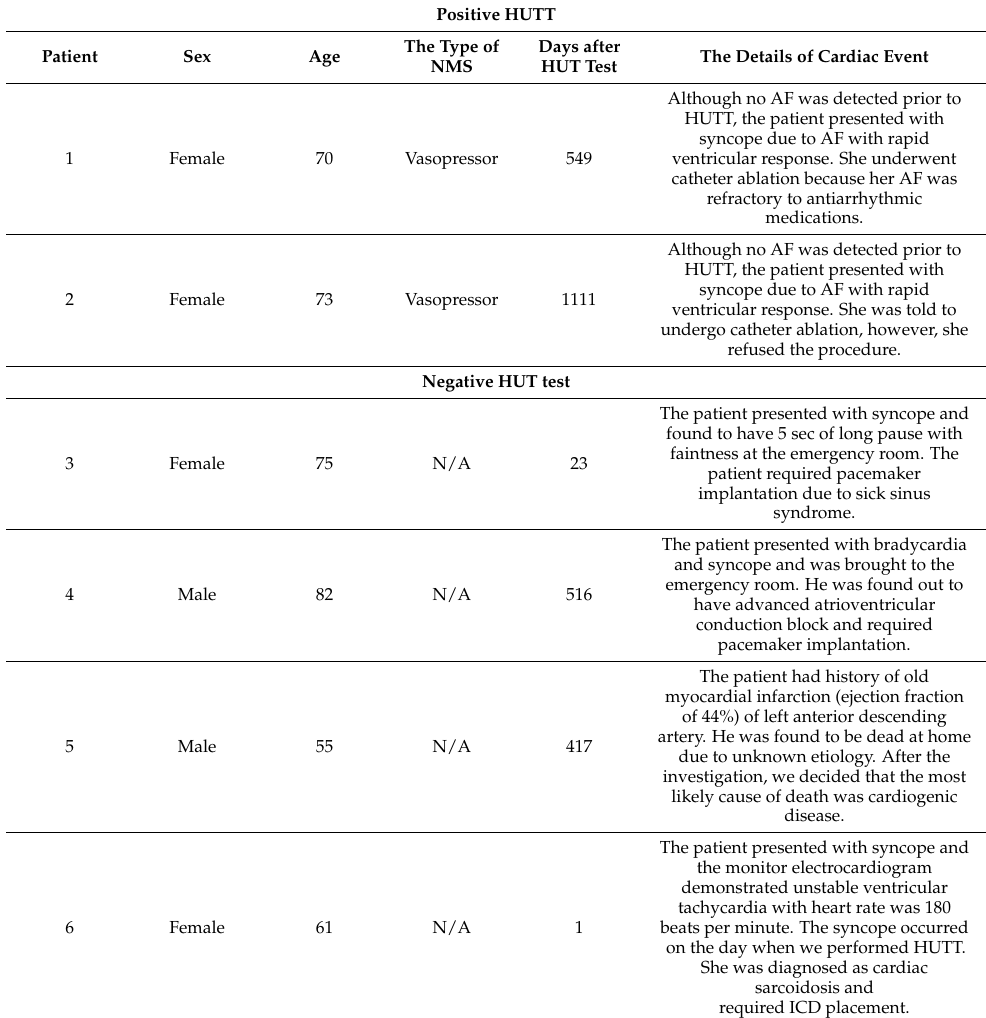
Table 3. Details of cardiac events in each